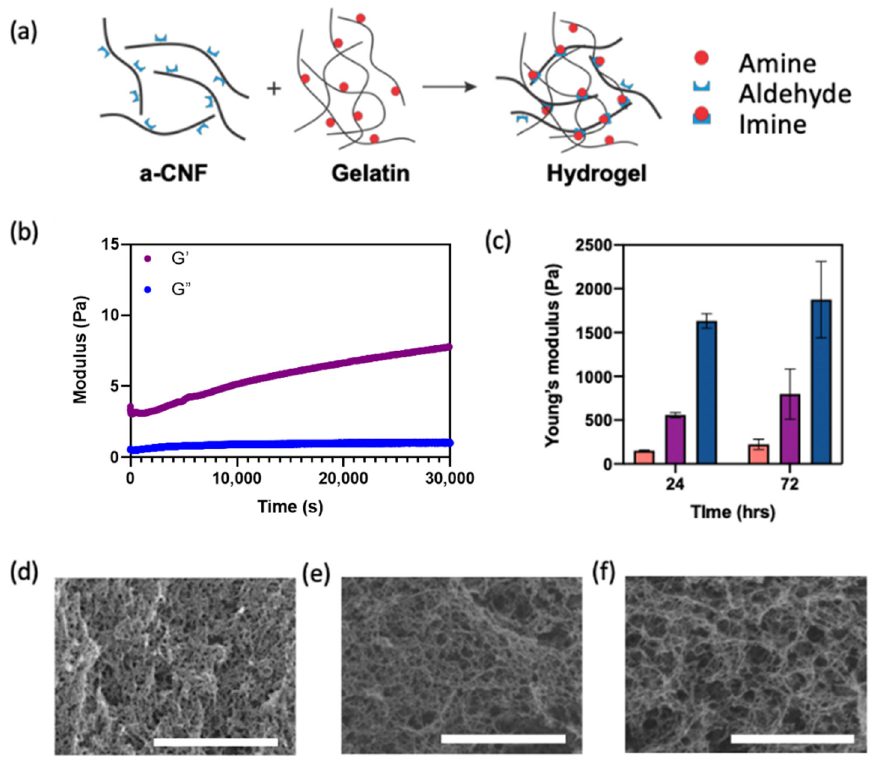
Figure 2. Properties of a-CNF/gelatin hydrogels. ( a ) Schematic of gel formation from a-CNFs and gelatin. ( b ) Rheological characterization of gel formation from the a-CNF/gelatin mixture at 37 °C, depicting the variation in storage modulus (red) and loss modulus (blue). C a-CNF = 0.50 wt.%; C gelatin = 4.0 wt.%. ( c ) Variation in the compression Young’s modulus of a-CNF/gelatin hydrogels at 37 °C at C a-CNF in the hydrogels of 0.33 wt.% (orange), 0.50 wt.% (purple), and 1.0 wt.% (blue). C gelatin = 4.0 wt.%. ( d – f ) Scanning electron microscopy (SEM) images of a-CNF/gelatin hydrogels at C a-CNF of 0.33 wt.% ( d ), 0.50 wt.% ( e ) and 1.0 wt.% ( f ) at C gelatin = 4.0 wt.%. Scale bars are 2 μ m.